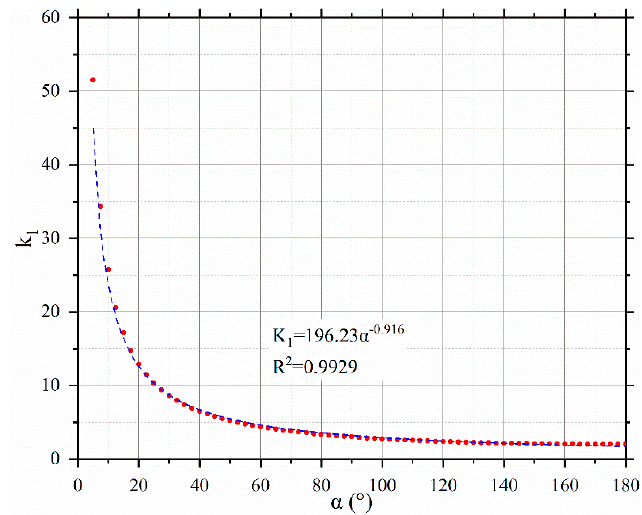
Figure 5. Power function regression curve of K 1 .